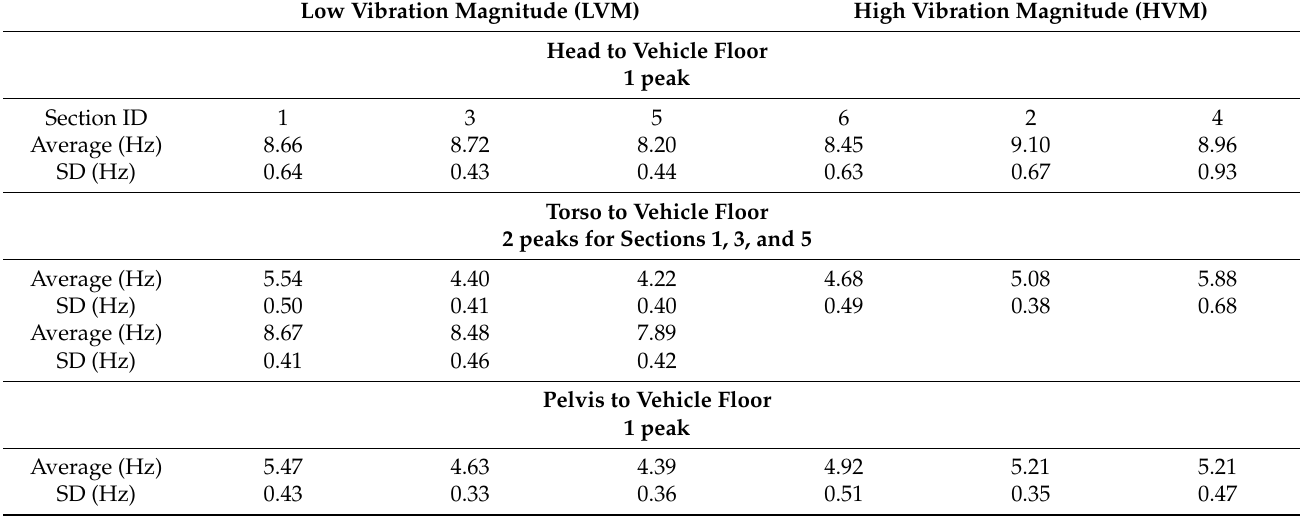
Table 1. The average prominent peak frequencies of the transmissibilities and the SD of the head, torso, and pelvis relative to the vehicle floor for all subjects for Sections 1–6 ordered in terms of vibration magnitudes.